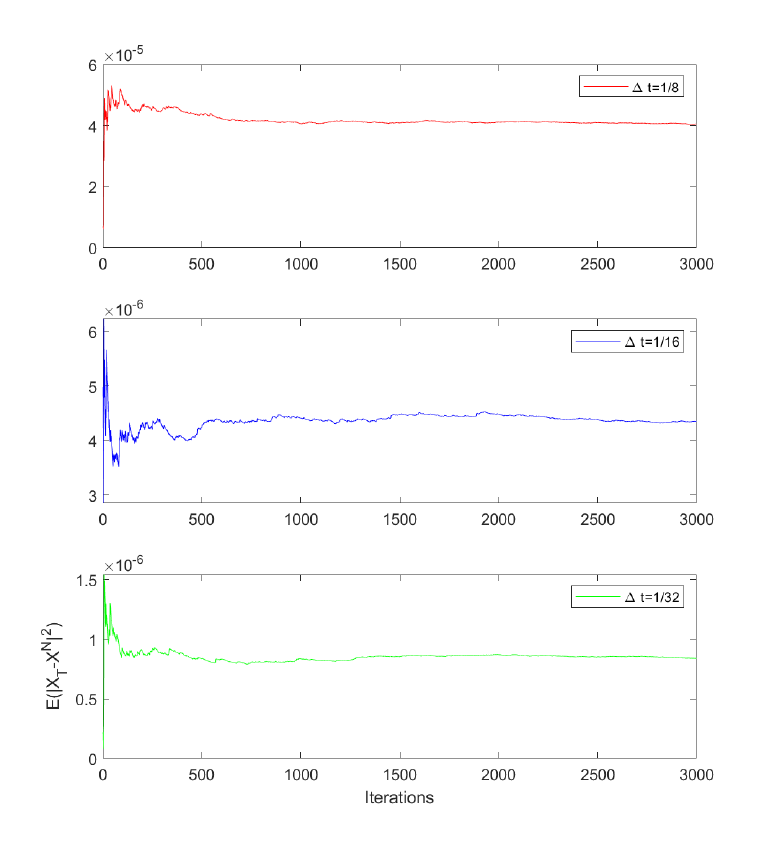
Figure 3. Mean − square stability of three kinds of time steps of global errors with New